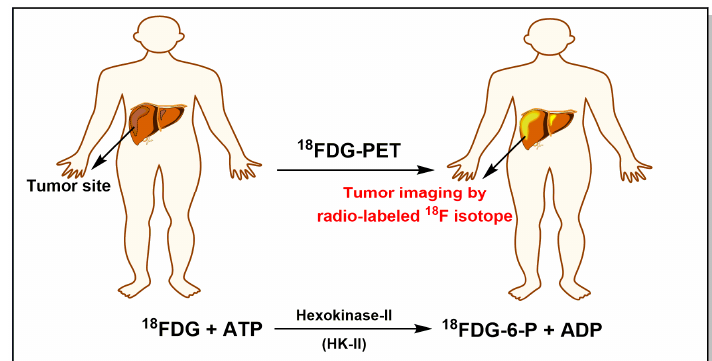
Figure 3. Schematic representation of tumor imaging by 18 F-fluorodeoxyglucose positron emission tomography ( 18 FDG-PET) technology.